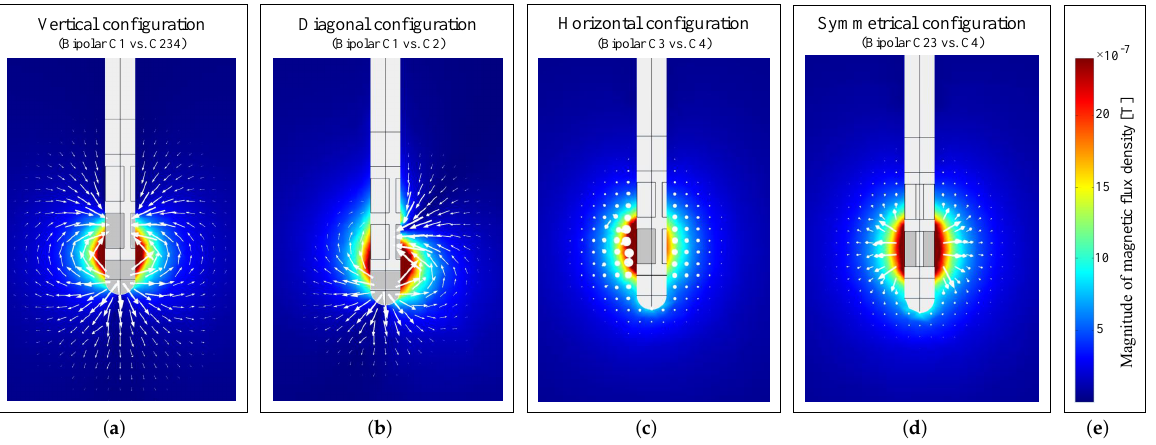
Figure 9. Electromagnetic simulation results of a ( a ) vertical, ( b ) diagonal, ( c ) horizontal, and ( d ) symmetrical electrode configuration, in which the magnetic field is shown in color and the direction of current flow is shown with white arrows. ( e ) Color legend applies to all